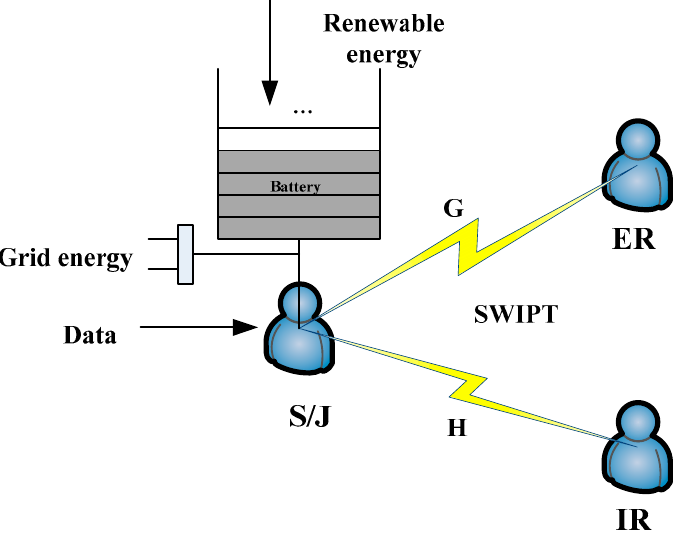
Figure 1. The system model.